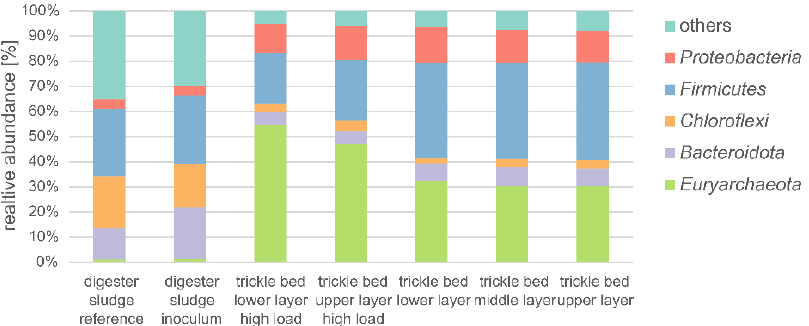
Figure 9. Overview of the microbial community dynamics analyzed by 16S rRNA gene amplicon sequencing displayed as relative abundance (%) on phylum level. Phyla with a relative abundance <10% are summarized as “others.”